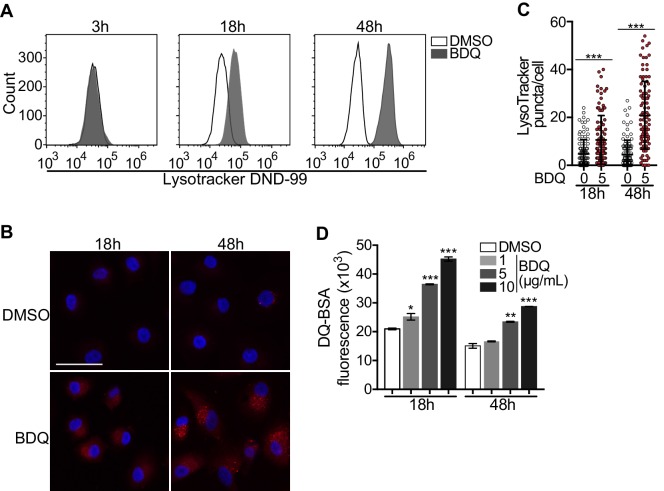
BDQ activates the lysosomal pathway in human naive macrophages.(A) Macrophages were incubated with BDQ (5 μg/mL) for 3 hr, 18 hr and 48 hr. Acid organelles were then labeled with 100 nM LysoTracker DND-99 for 1 hr. The fluorescence intensity was quantified by flow cytometry. (B–C) Cells were treated with BDQ (5 μg/mL). After 18 hr and 48 hr of treatment, cells were labeled with LysoTracker (red) and fluorescence was analyzed by confocal microscopy. DAPI (blue) was used to visualize nuclei (scale bar: 10 μm). The quantification of LysoTracker staining and the percentage of LysoTracker-positive MTB phagosomes were performed using Icy software. (D) Macrophages were left untreated or treated with BDQ for 18 hr and 48 hr. Cells were then incubated with DQ-Green BSA. Fluorescence was quantified by flow cytometry. Significant differences between BDQ treatment and control (DMSO) are indicated by an asterisk. One representative experiment (of at least three) is shown. Error bars represent the mean ± SD. *p<0.05, **p<0.01, ***p<0.001.